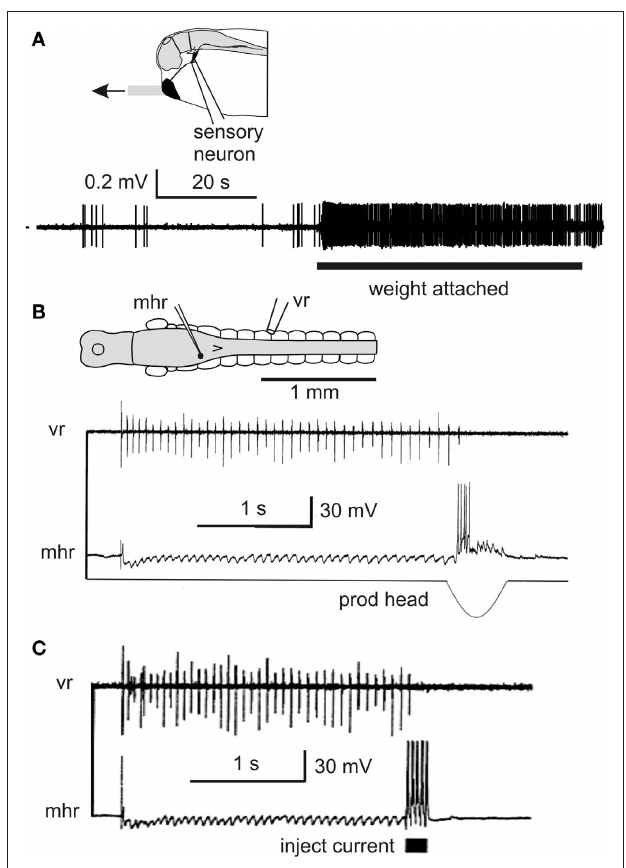
Figure  | inhibitory pathways stop swimming and reduce responses. (A) Impulse recording from trigeminal sensory neuron innervating the cement gland shows the resting discharge and increased firing when the cement gland mucus strand is in tension. (based on Lambert et al., 2004a) (B) Intracellular recording from an mhr, with long descending contralateral axon in spinal cord, shows it is inhibited during swimming and fires when the cement gland is prodded and swimming stops (C) . Injecting current to make this single mhr fire can stop swimming. (based on Perrins et al.,